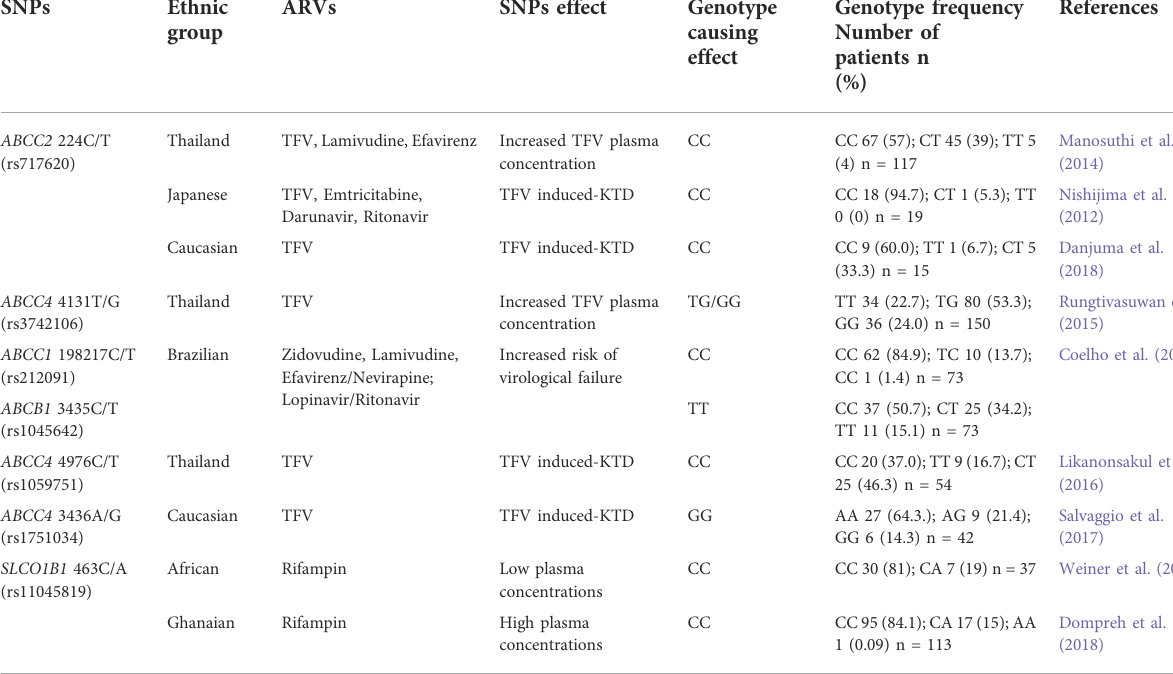
TABLE 3 Effects of SNPs in drug transporter genes involved in the pharmacokinetics of ARVs in different ethnic